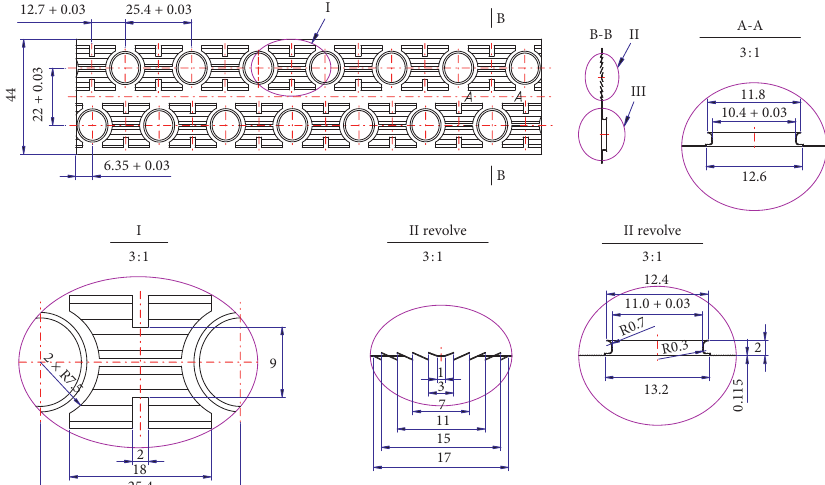
Figure 2: Heat exchanger fin.